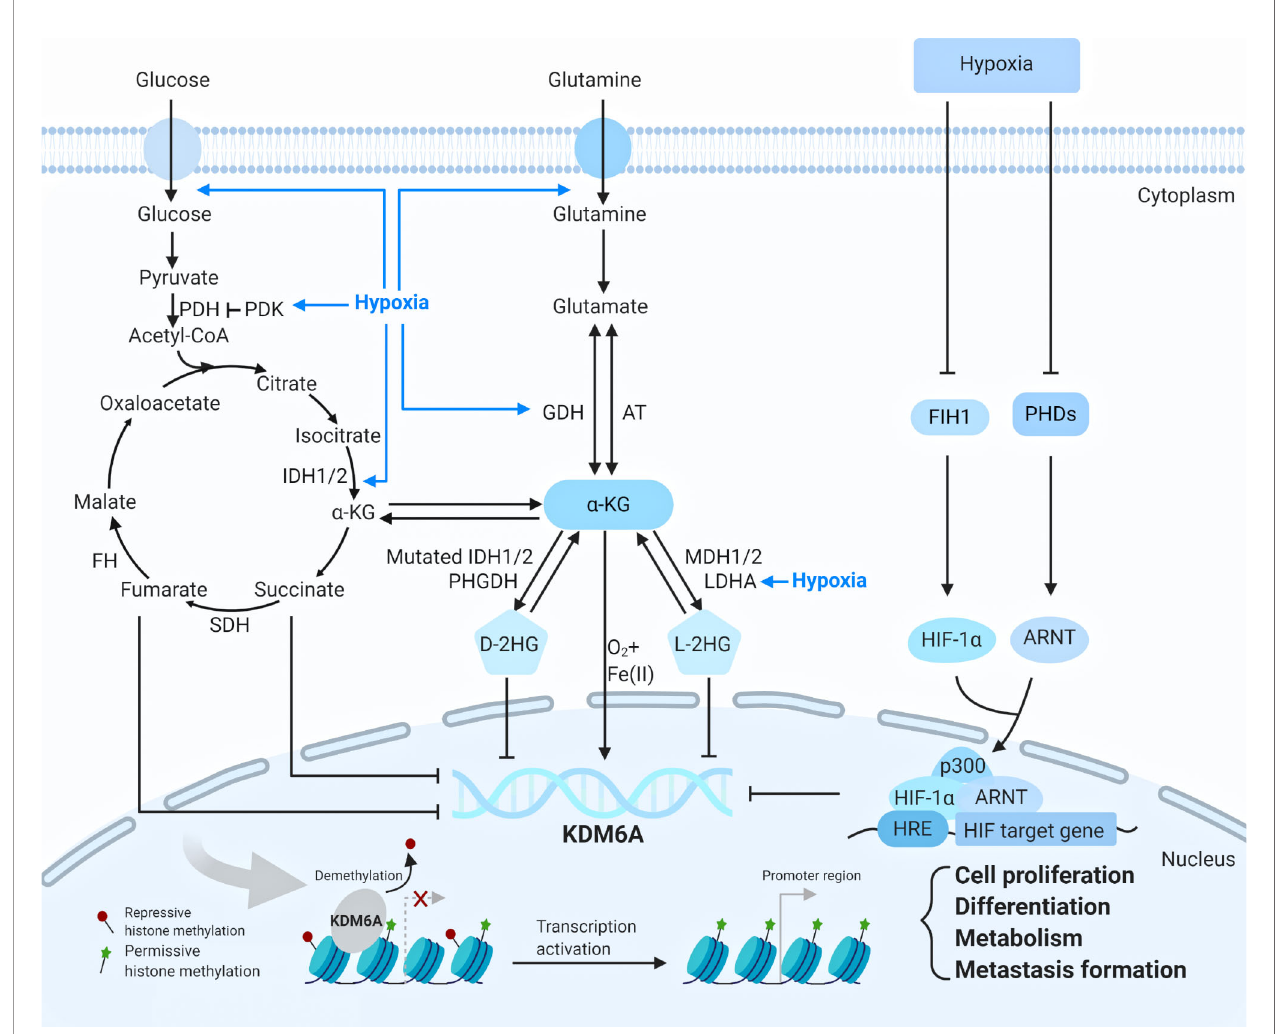
FIGURE 2 | The regulation of KDM6A (Created with BioRender.com). KDM6A is upregulated or downregulated by metabolic reactions and hypoxia through diverse mechanisms. KDM6A is re-cruited to the chromatin and respond to the transcription through in fl uencing cell proliferation, differentiation, metabolism and metastasis formation. ARNT, aryl hydrocarbon nuclear translocator, AT amino transferases, D-2HG D-2-hydroxyglutarate, FH fumarate hydratase, FIH1 factor-inhibiting hypoxia- inducible factor 1, GDH glutamate dehydrogenases, HIF-1 a hypoxia-inducible factor-1 a , HRE hypoxia response element, IDH1/2 isocitrate dehydrogenases 1 or 2, LDHA lactate dehydrogenase A, L-2HG L-2- hy-droxyglutarate, MDH 1/2 malate dehydrogenase 1 or 2, PDH pyruvate dehydrogenase, PHDs prolyl hydroxylases, PDK pyruvate dehydrogenase kinase, PHGDH D-3-phosphoglycerate, SDH succinate dehydrogenase, a -KG a